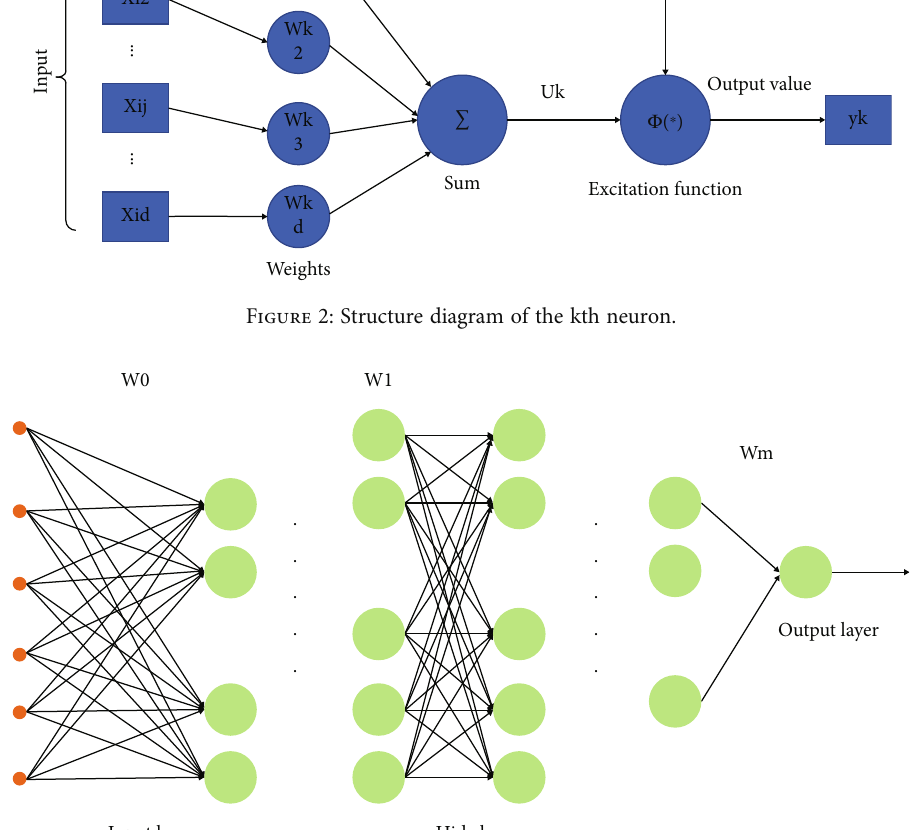
Figure 3: Topological structure diagram of m-layer of neural network.